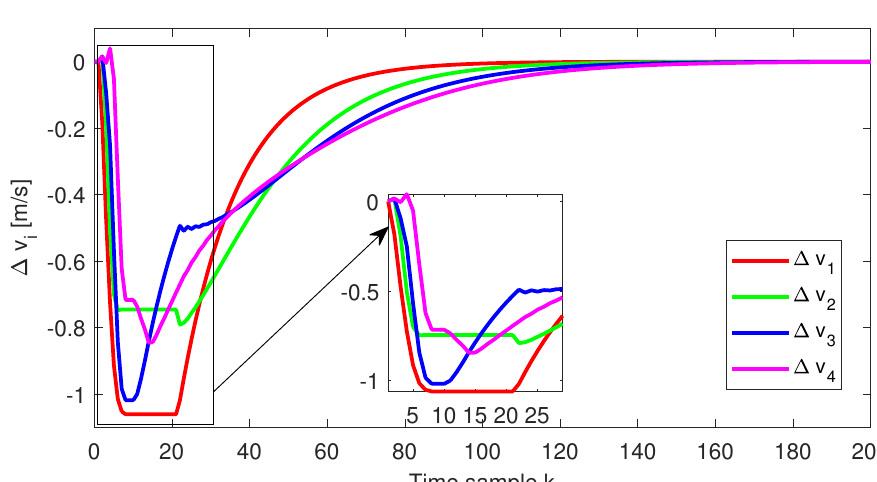
Figure 5. Test 4 —Relative speed for each platoon